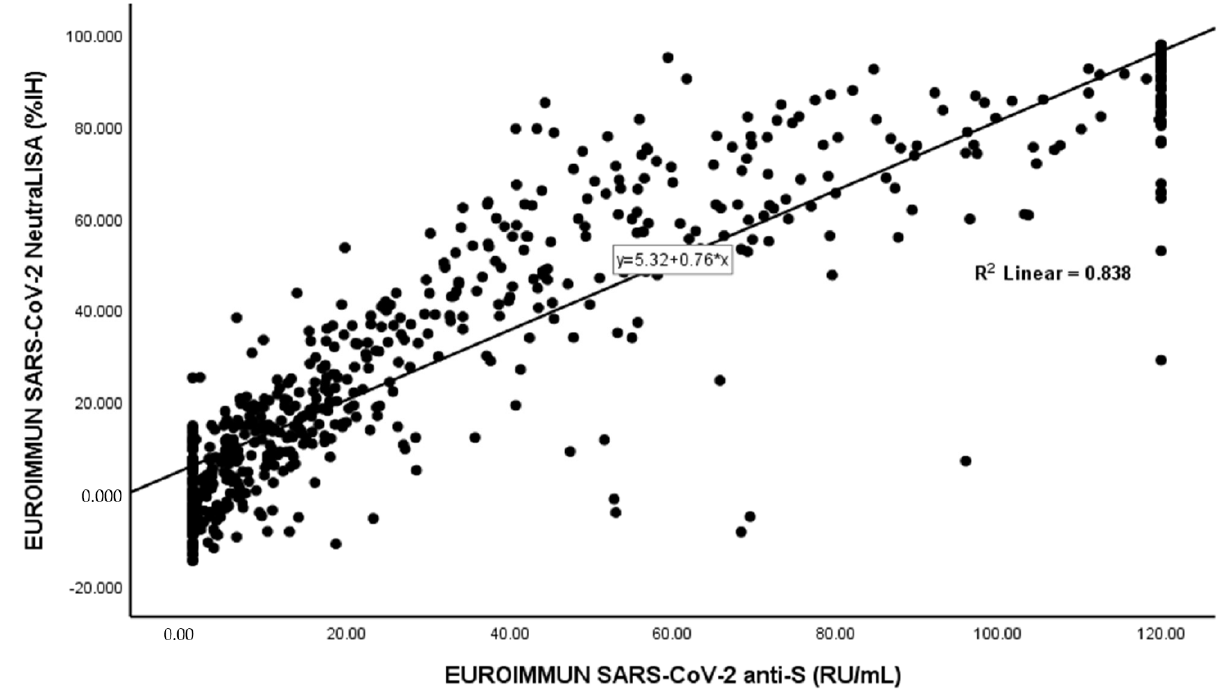
Figure 1. Correlation of EUROIMMUN SARS-CoV-2 anti-S (RU/mL) with EUROIMMUN SARS-CoV-2 NeutraLISA (%IH)* (n = 650).